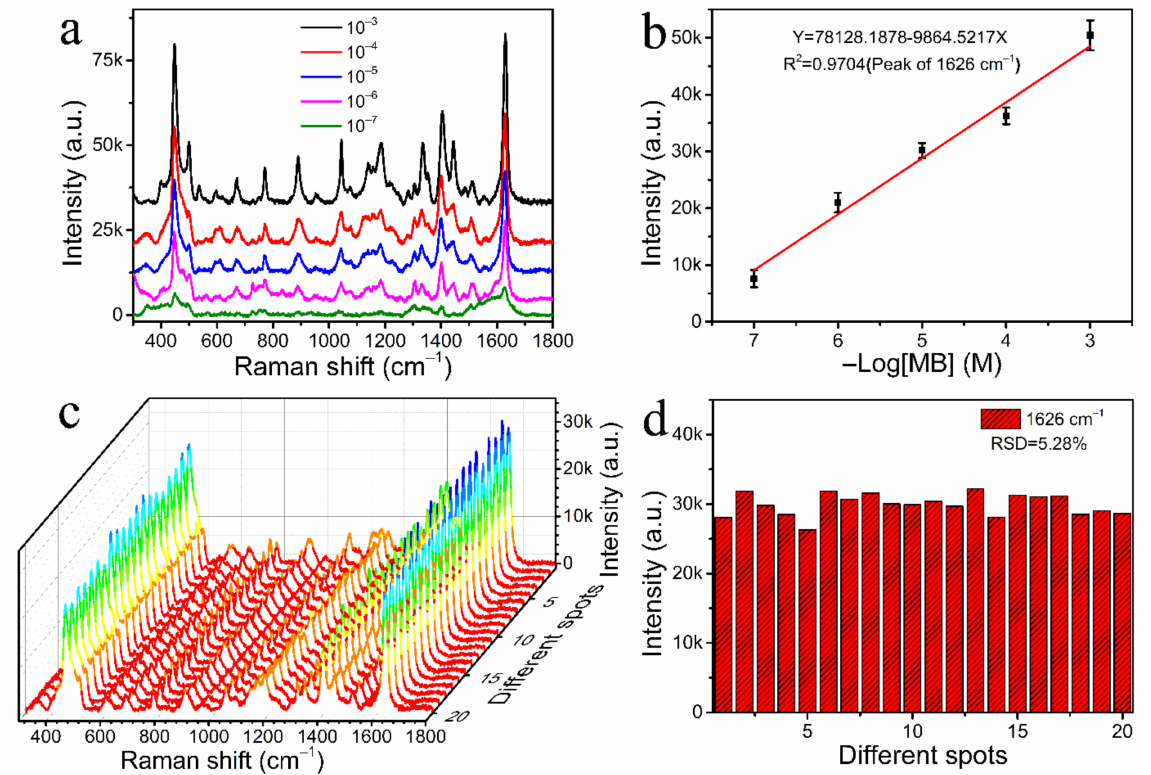
Figure 7. ( a ) SERS spectra obtained by employing 10 − 3 to 10 − 7 M of MB on the hydrophobic CFP@PDA@AuNPs substrates. ( b ) Linear fit diagram between the Raman intensity of MB at 1626 cm − 1 and the negative logarithm of the sample concentration. ( c ) Waterfall graph of MB (10 − 5 M) SERS signals recorded from 20 selected sites on the hydrophobic CFP@PDA@AuNPs sub- strate. ( d ) Signal intensity map of MB collected at 1626 cm − 1 from 20 selected sites on the same hydrophobic